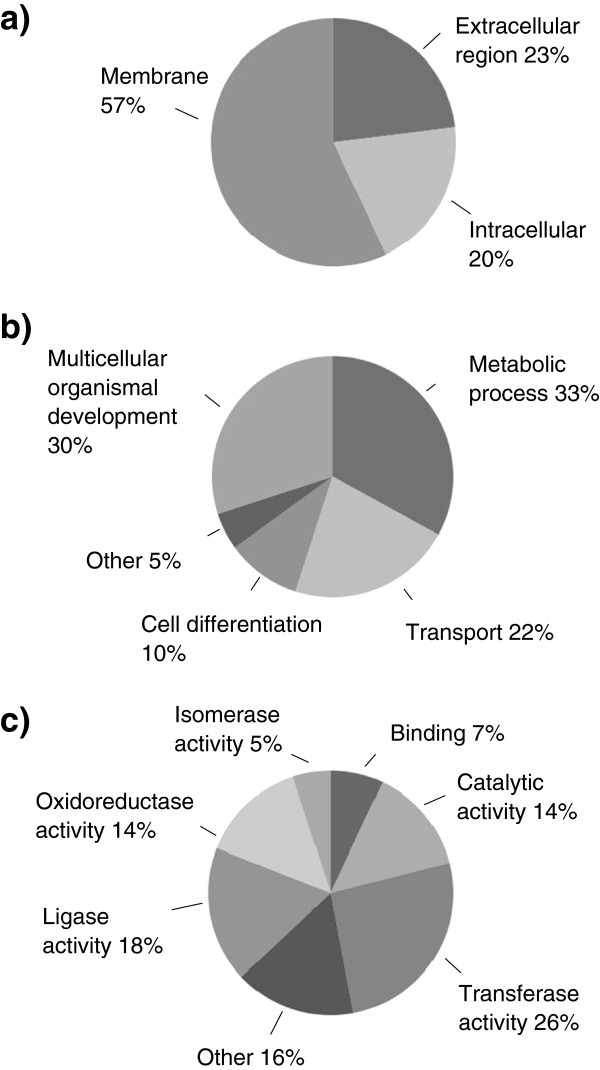
High level GO classification of unigenes from the subtracted library. a: Cellular Component Ontology, b: Biological Process Ontology, c: Molecular Function Ontology.